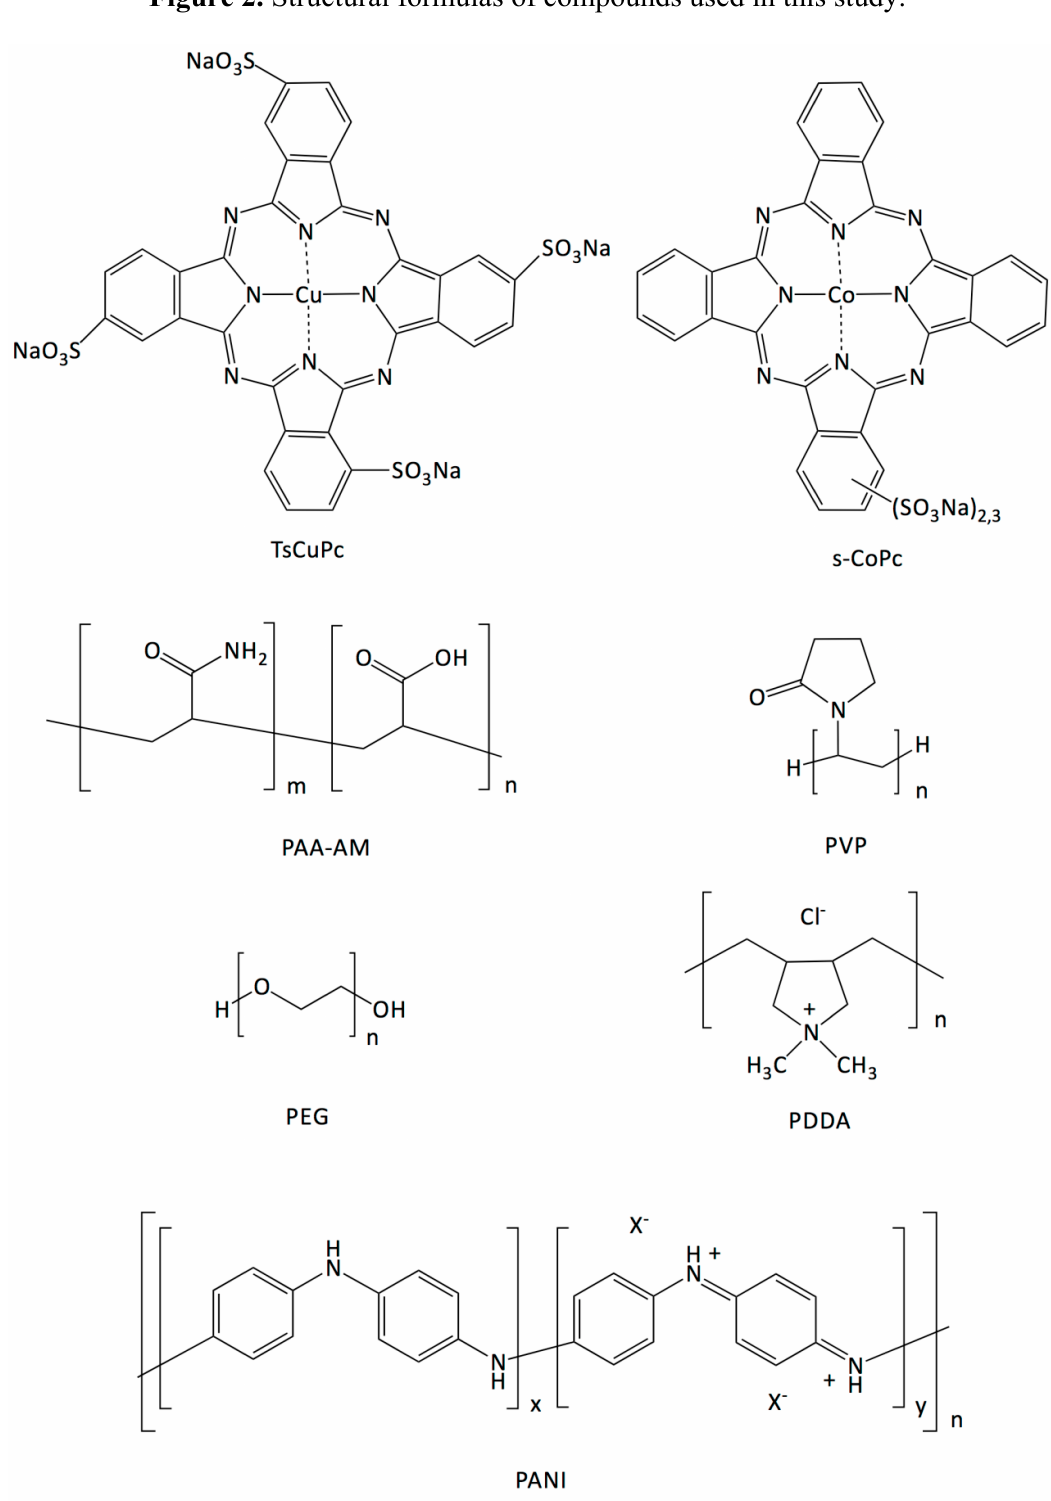
Figure 2. Structural formulas of compounds used in this